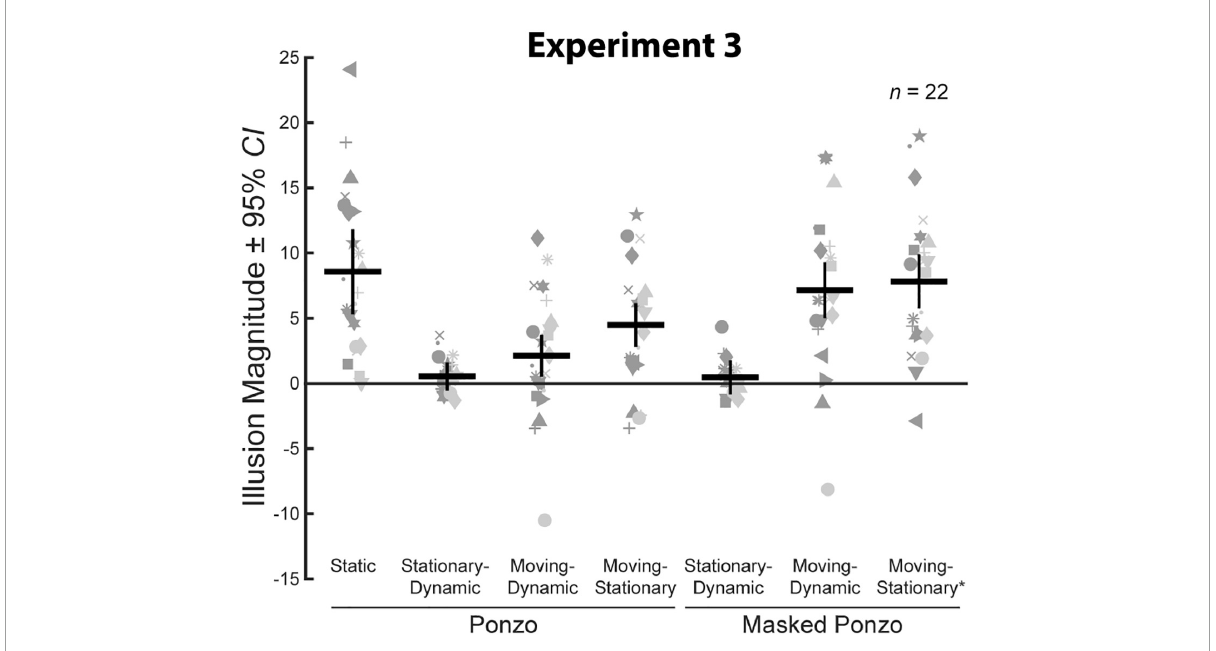
FIGURE7 Illusion magnitudes for the seven conditions with a surrounding context in Experiment 3. Conventions are the same as in Figure 3 . Statistical comparisons against zero and across conditions are summarized in Table 3